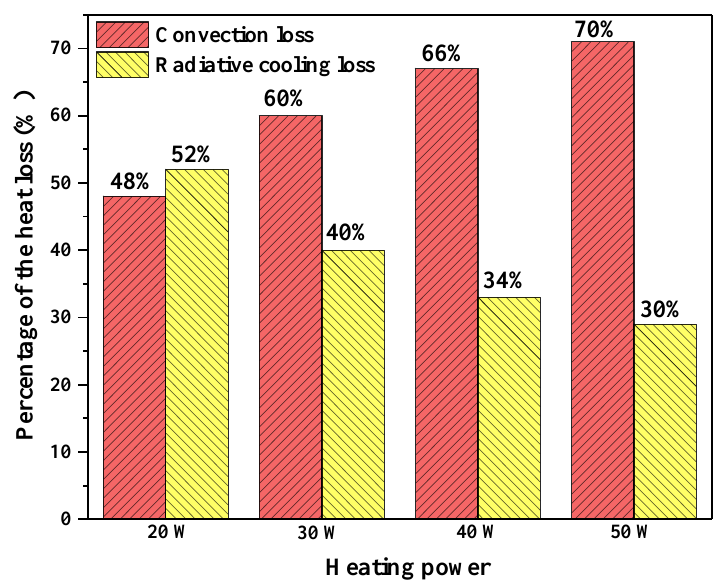
Figure 18. The proportion of convection and radiation to total heat dissipation with di ff erent heating powers.